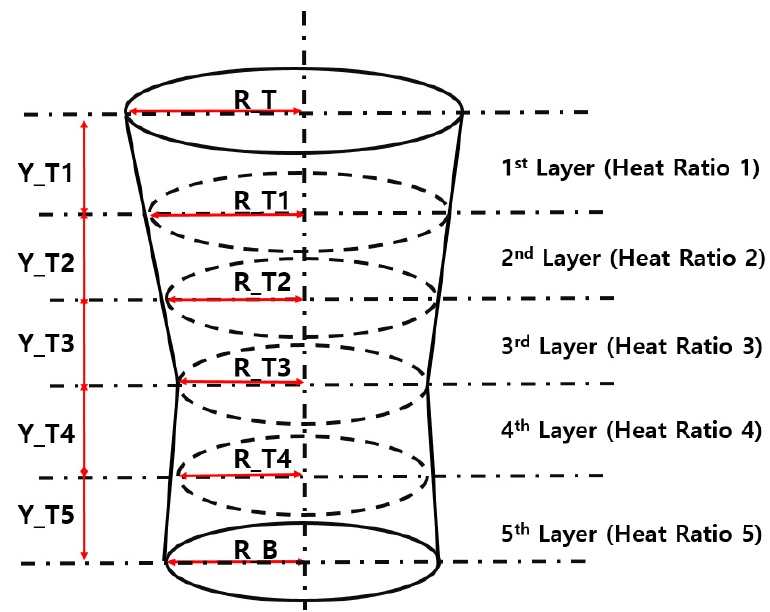
Figure 6. Multi-layered laser welding heat source model.